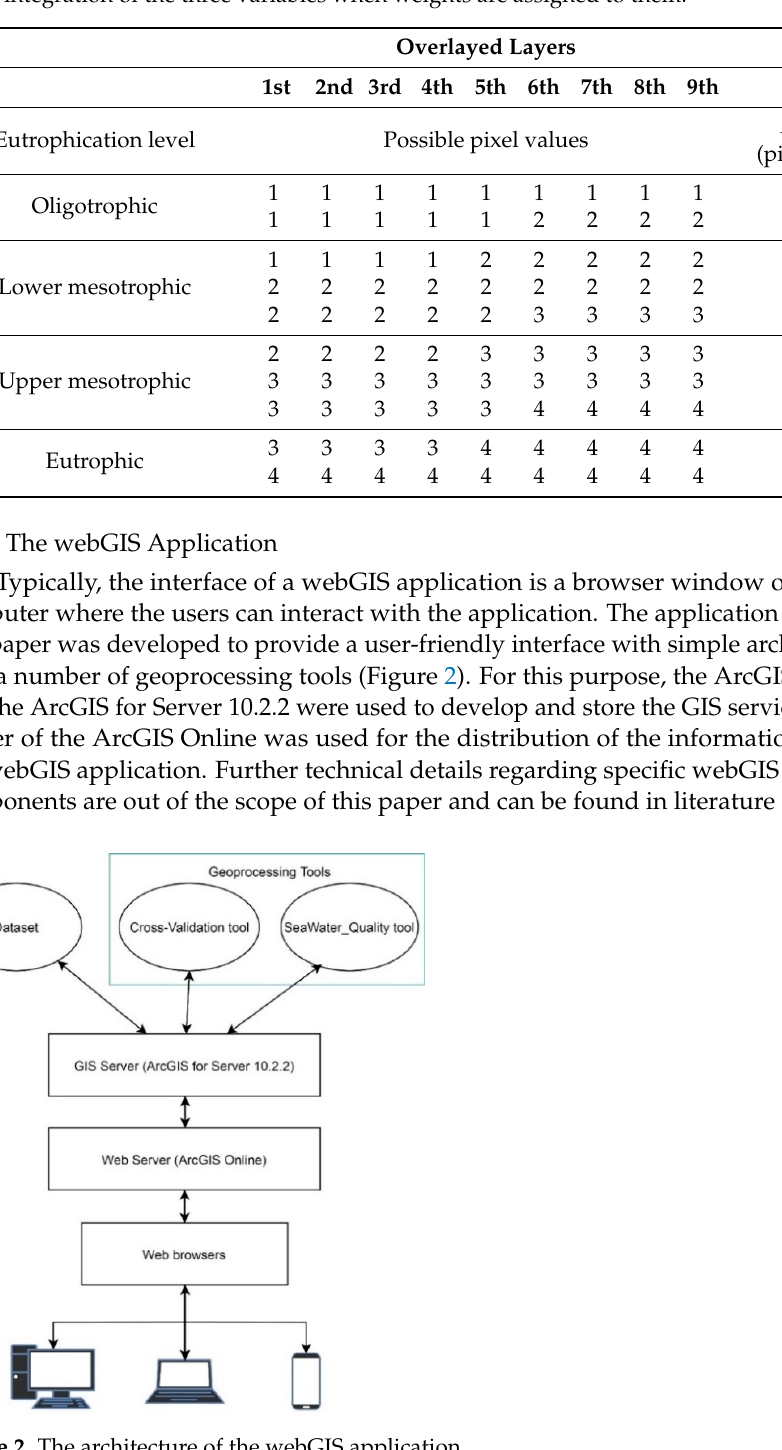
Table 3. Eutrophication scale for the classification of the pixel values of the result of the integration of the three variables when weights are assigned to them.